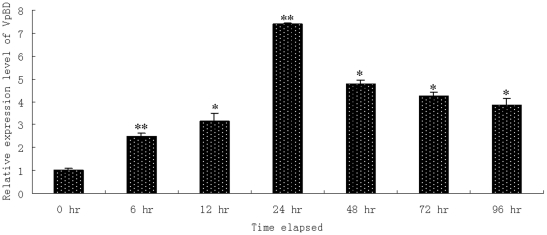
Time-course expression level of VpBD transcript in haemocytes after Vibrio anguillarum infection measured by quantitative real-time PCR at 0 hr, 6 hr, 12 hr, 24 hr, 48 hr, 72 hr and 96 hr.Each symbol and vertical bar represented the mean ± S.D (n = 5). Significant differences between challenged group and control group were indicated by an asterisk (P<0.05) and two asterisks (P<0.01), respectively.